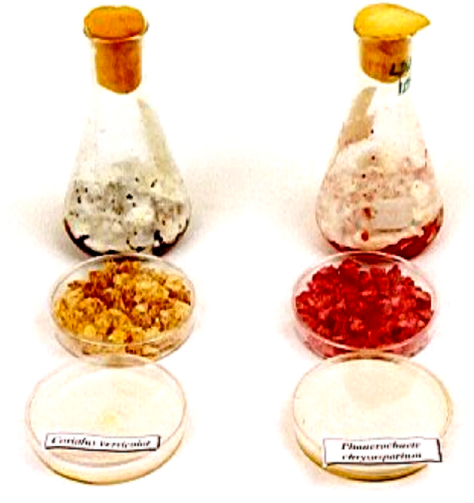
Figure 2. Growth of two white-rot fungi Phanerochaete chrysosporium and Coriolus versicolor in the fermentation of dye-adsorbed substrates. (Picture taken by author P. Nigam from lab experiment, not published anywhere).